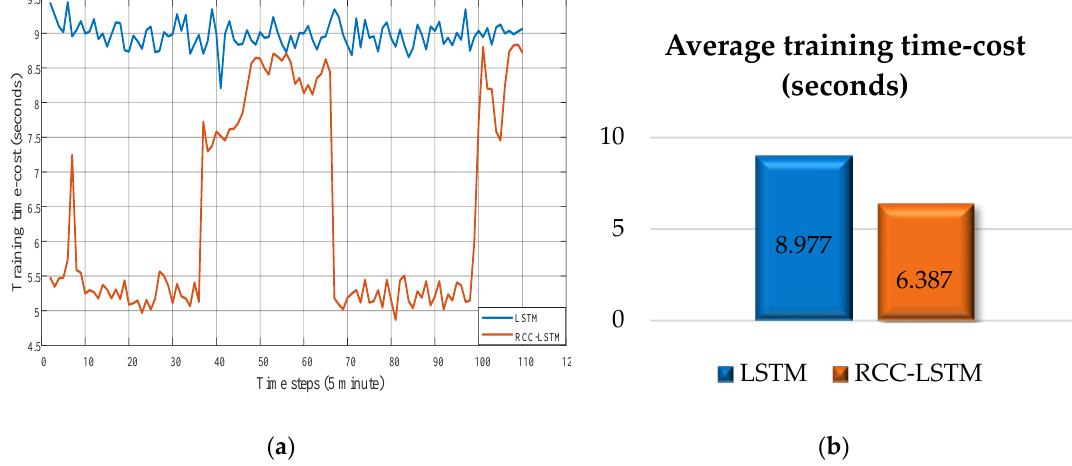
Figure 18. ( a ) The average training time-cost at different time point; ( b ) The average training time-cost of different models.